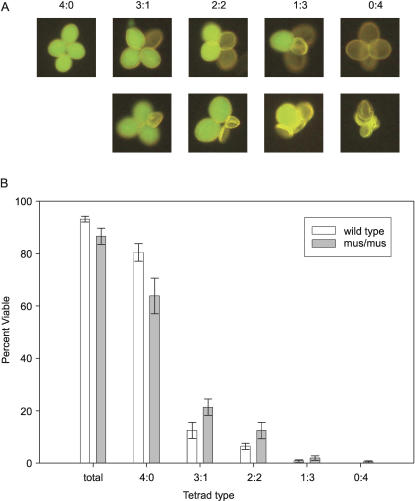
Pollen Viability in Wild Type and Atmus81 Mutants(A) Pollen tetrads from plants homozygous for three different fluorescent markers were examined. Pollen was classified as nonviable if grains were aborted (bottom row) or if all of the fluorescent proteins were not expressed (top row).(B) The Atmus81 mutant has lower levels of pollen viability. Viability of wild type (open bars) is compared to Atmus81/Atmus81 plants (gray bars) and is also broken into tetrad categories (4:0, 3:1, 2:2, 1:3, 0:4; viable:nonviable). Error bars are +/− the standard error of the mean.